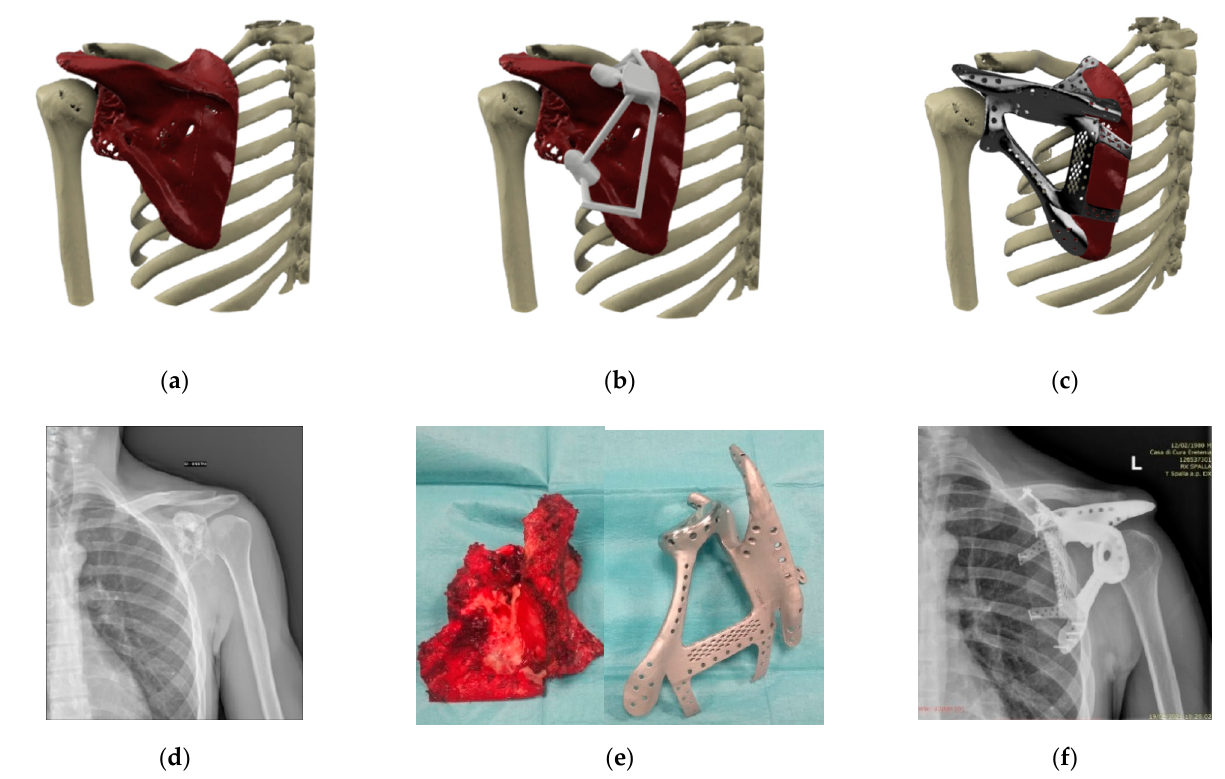
Figure 1. Case #10, Male 36 years, low grade osteosarcoma, 3D-virtual model of ( a ) low grade osteosarcoma of the left glenoid, ( b ) PSI cutting guide, ( c ) custom made prosthesis, ( d ) pre-operative plain x-ray, ( e ) surgical specimen and custom-made prostheses, and ( f ) plain x-ray (three years follow up).